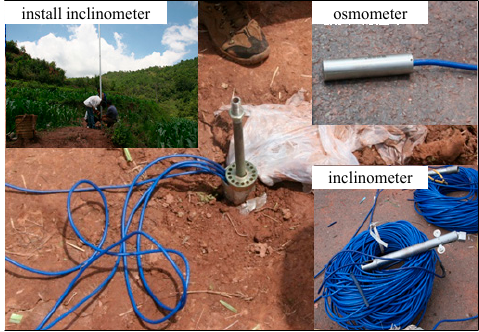
Figure 2. Embedded inclinometer and